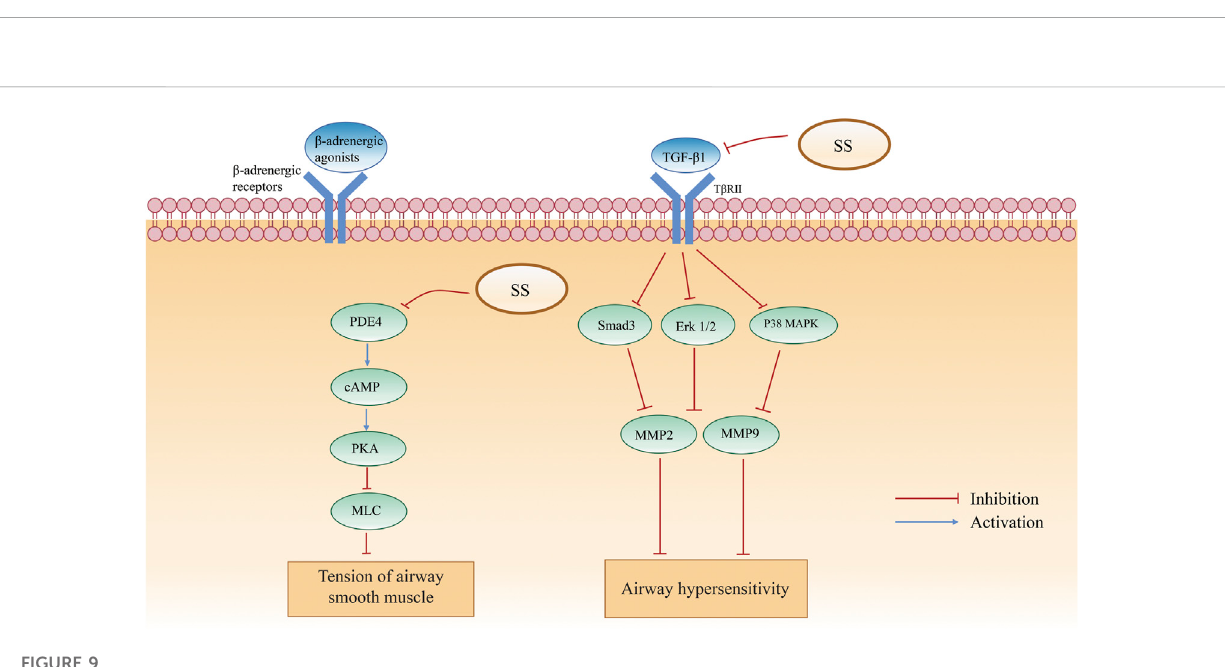
FIGURE 9 Signaling pathways of reducing airway sensitivity of